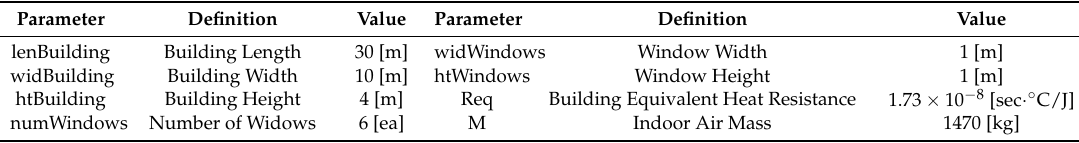
Figure 5. Comparison of indoor and outdoor temperatures (without a heating, ventilation, and air-conditioning (HVAC) system). Table 1. Configuration data of the